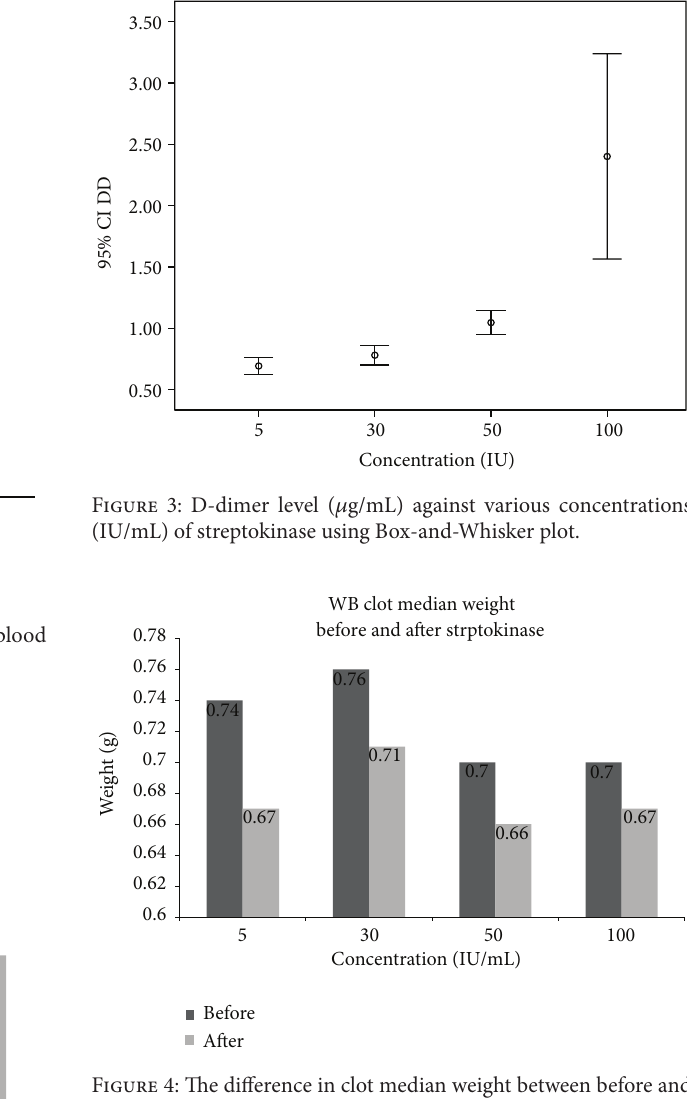
Figure 4: The difference in clot median weight between before and after SK induced